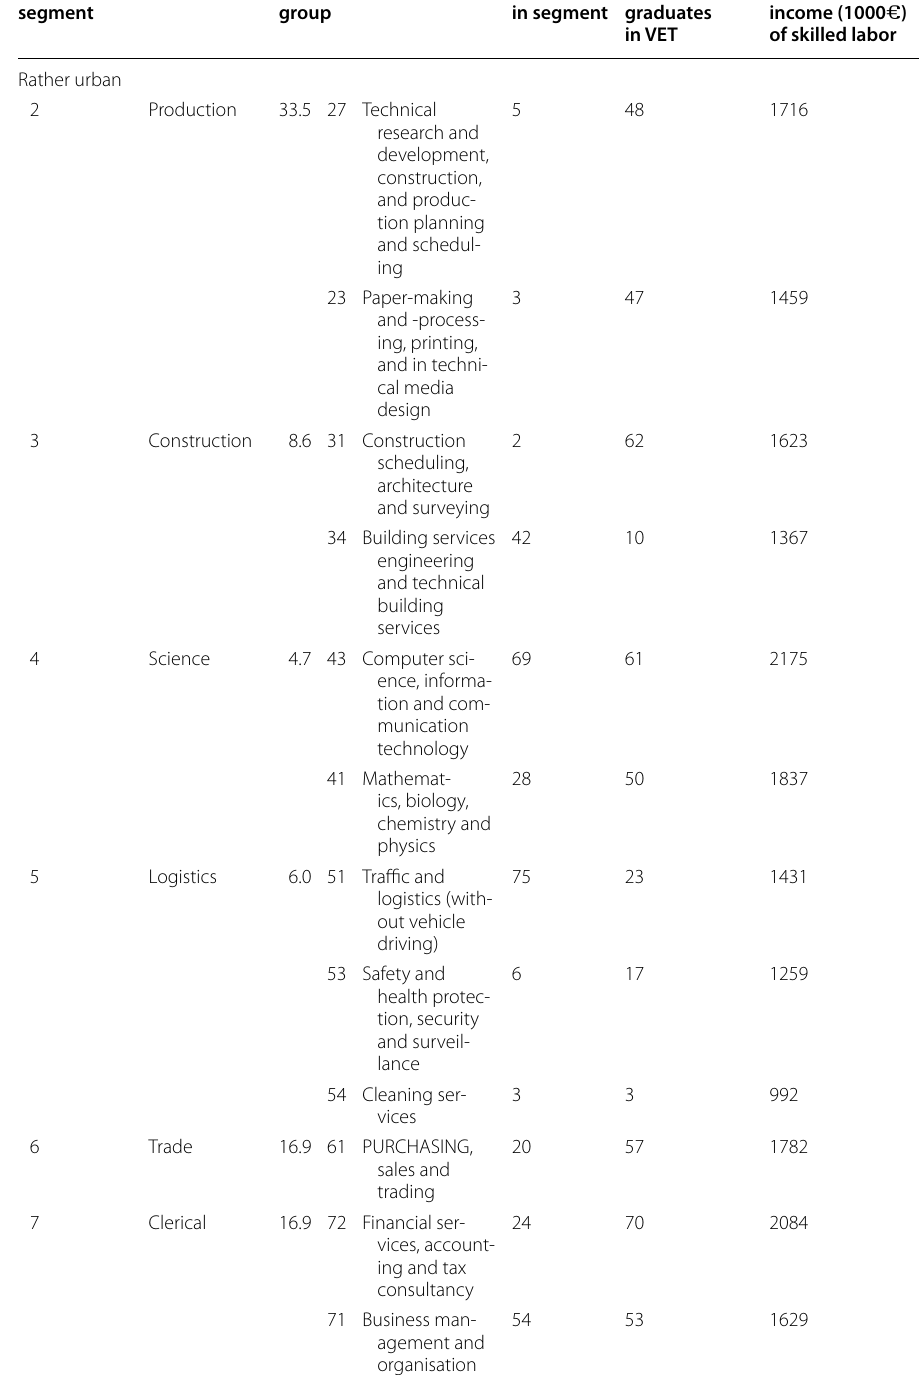
Table 1 Relevant occupational characteristics by typical location type Occupational Share in total Occupational main segment group Rather